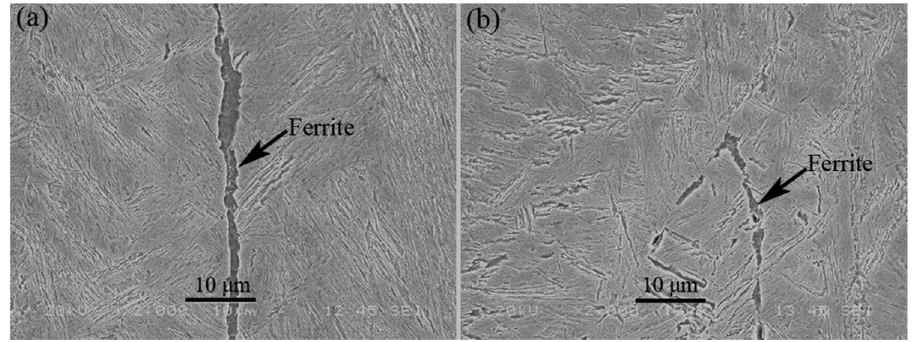
Figure 16: Microstructures near fracture surface at 700°C with a strain rate of 0.005 s − 1 observed by SEM: ( a ) steel 5# - 0% V; ( b ) steel 6# - 0.12% V.